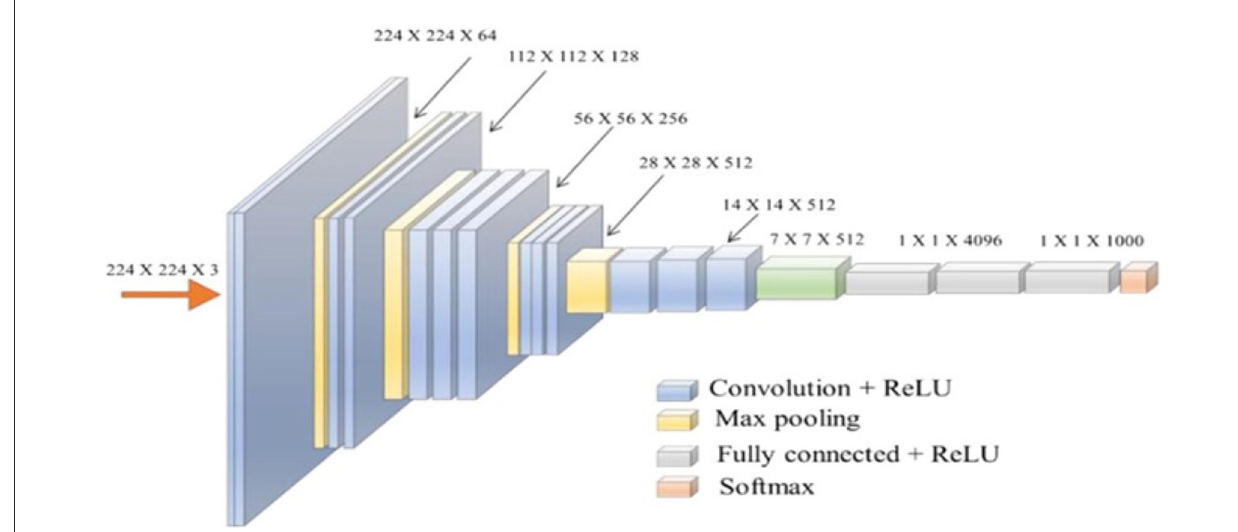
FIGURE7 The standard VGG-16 network architecture (Simonyan and Zisserman, 2014).